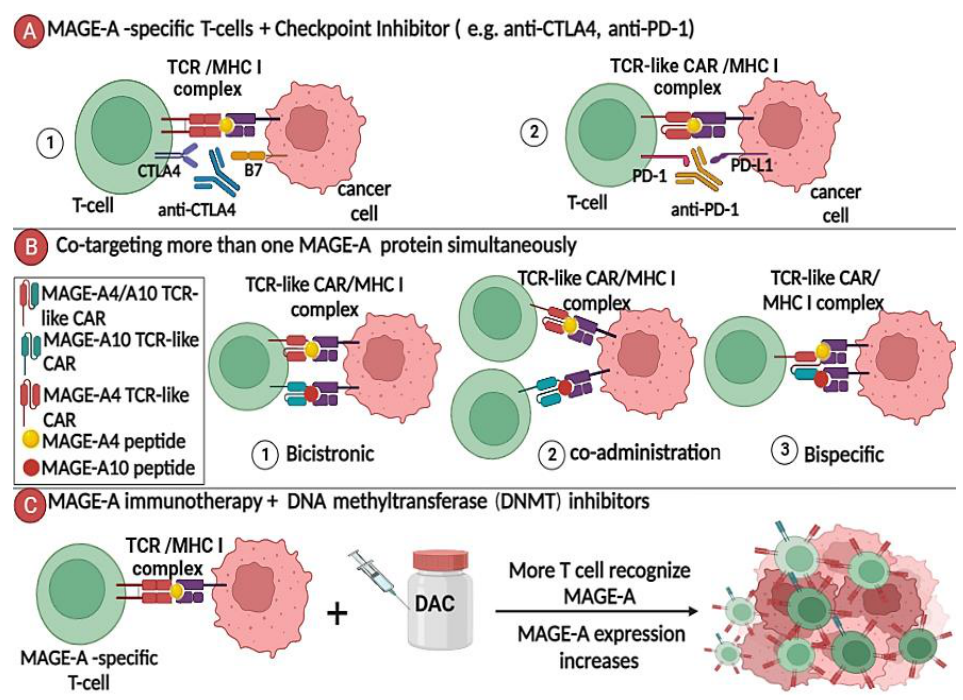
Figure 3. Targeting the MAGE-A antigen in combination with other therapies: proposed ap- proaches. ( A ) TCR/TCR-like CAR-engineered T cells specific for MAGE-As could be combined with